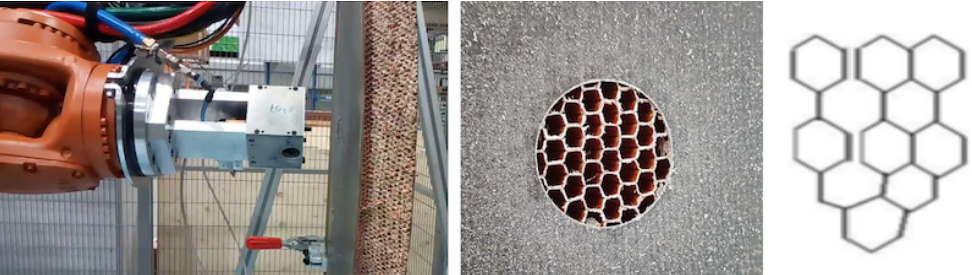
Figure 10. LEFT : Picture of the end-effector prototype dedicated to the CFRP-skin removal operation mounted on the robotic arm and ready for the milling. MIDDLE : The result of the skin-removal for 39 mm diameter milling. The core cells are exposed, preserving the cell integrity, and without burrs, ready for potting. RIGHT : The integrity of the core can be compromised if cell walls are split or damaged, as in the drawing. This can be the result of the insertion of the resin injectors or due to milling with blunt tools or too deep into the